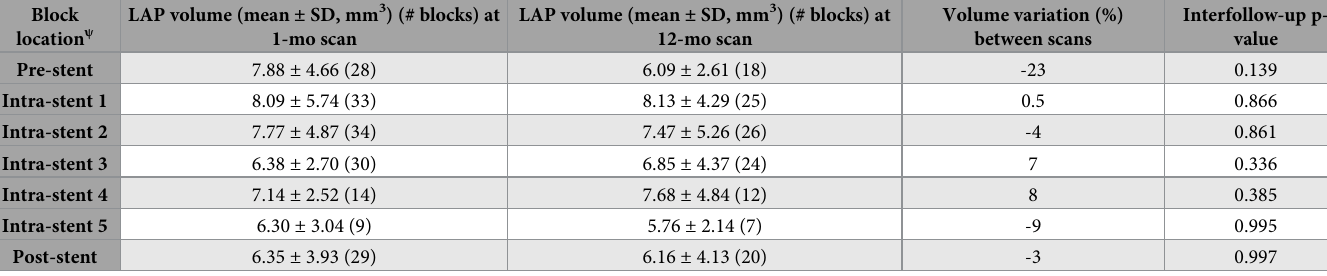
Table 8. Absolute LAP volume at 1- and 12-month follow-up by block location (pre-, intra 1-, 2-, 3-, 4-, 5-, and post-stent blocks). LAP volume (mean ± SD, mm 3 ) (# blocks) at Block 1-mo scan location ψ